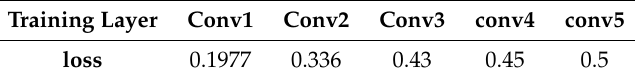
Table 5. Reconstruction loss of each layer